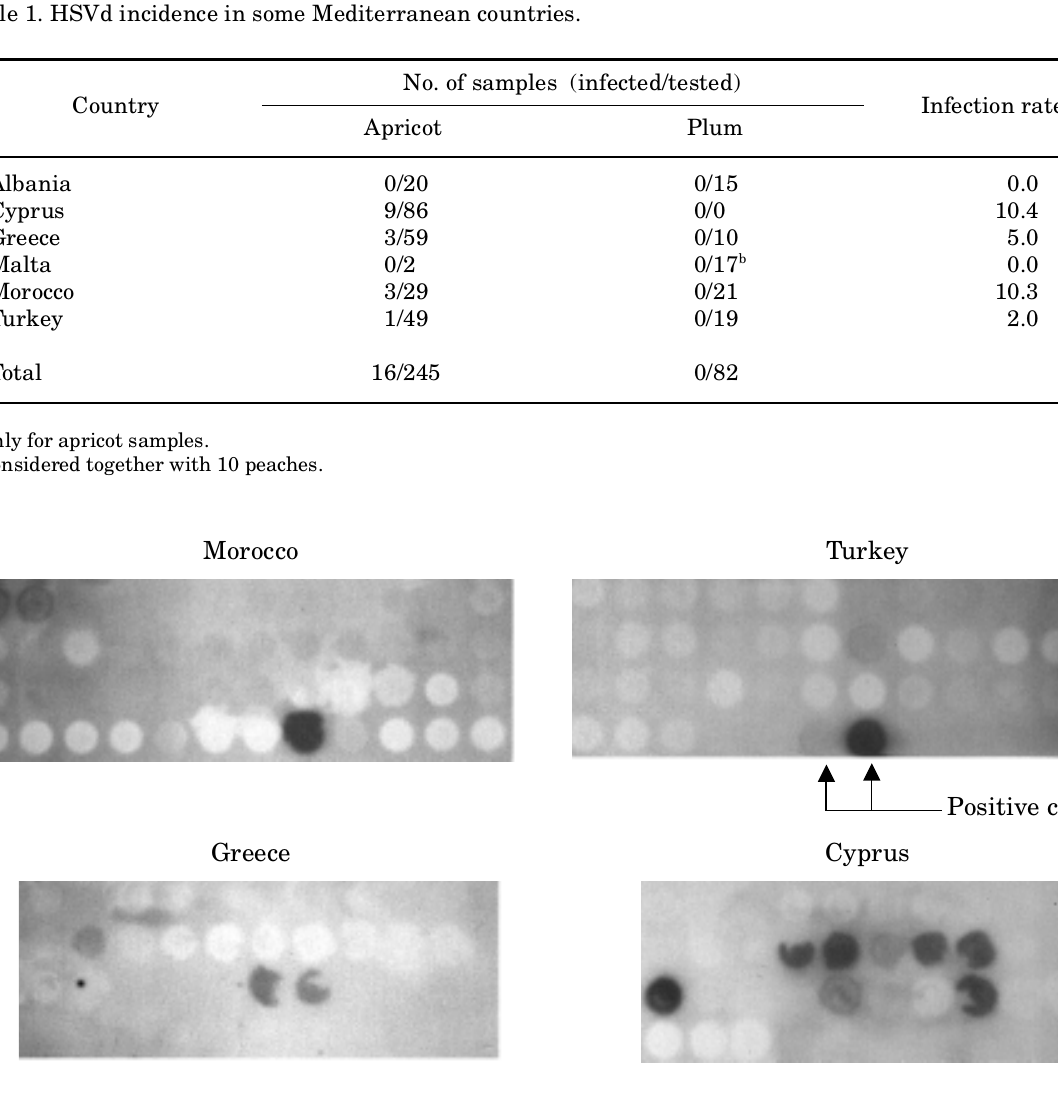
Fig. 1. HSVd detection by non-isotopic molecular hybridisation of those samples from four countries in which at least one positive reaction was observed (3 for Morocco, 1 for Turkey, 9 for Cyprus and 3 for Greece). Positive controls for the Turkey membrane are marked. Leaf samples were processed by a non-organic extraction procedure, denatured and applied to nylon membranes. The films were exposed for 30